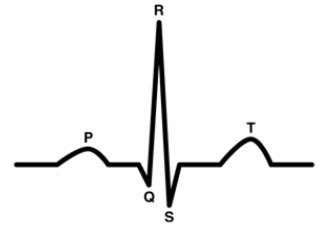
A normal ECG beat.